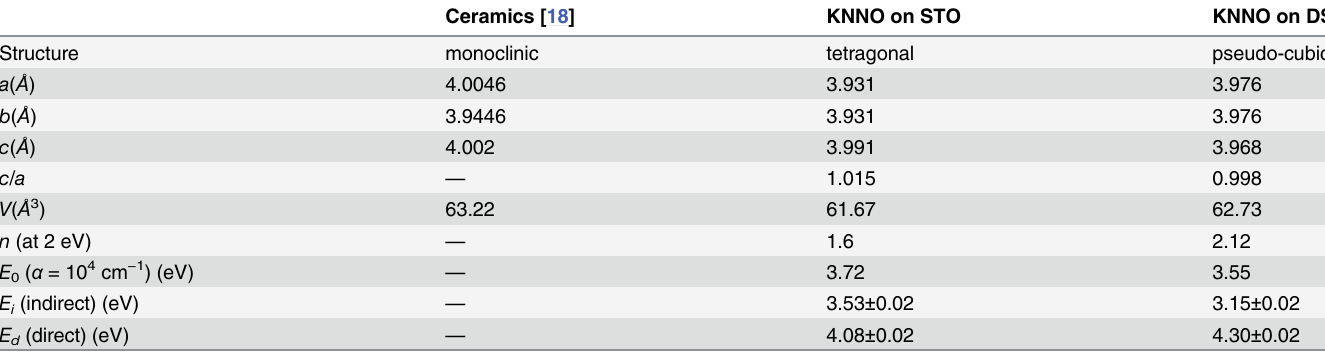
Table 1. Summary of structural and optical properties in ceramics and thin-film KNNO.